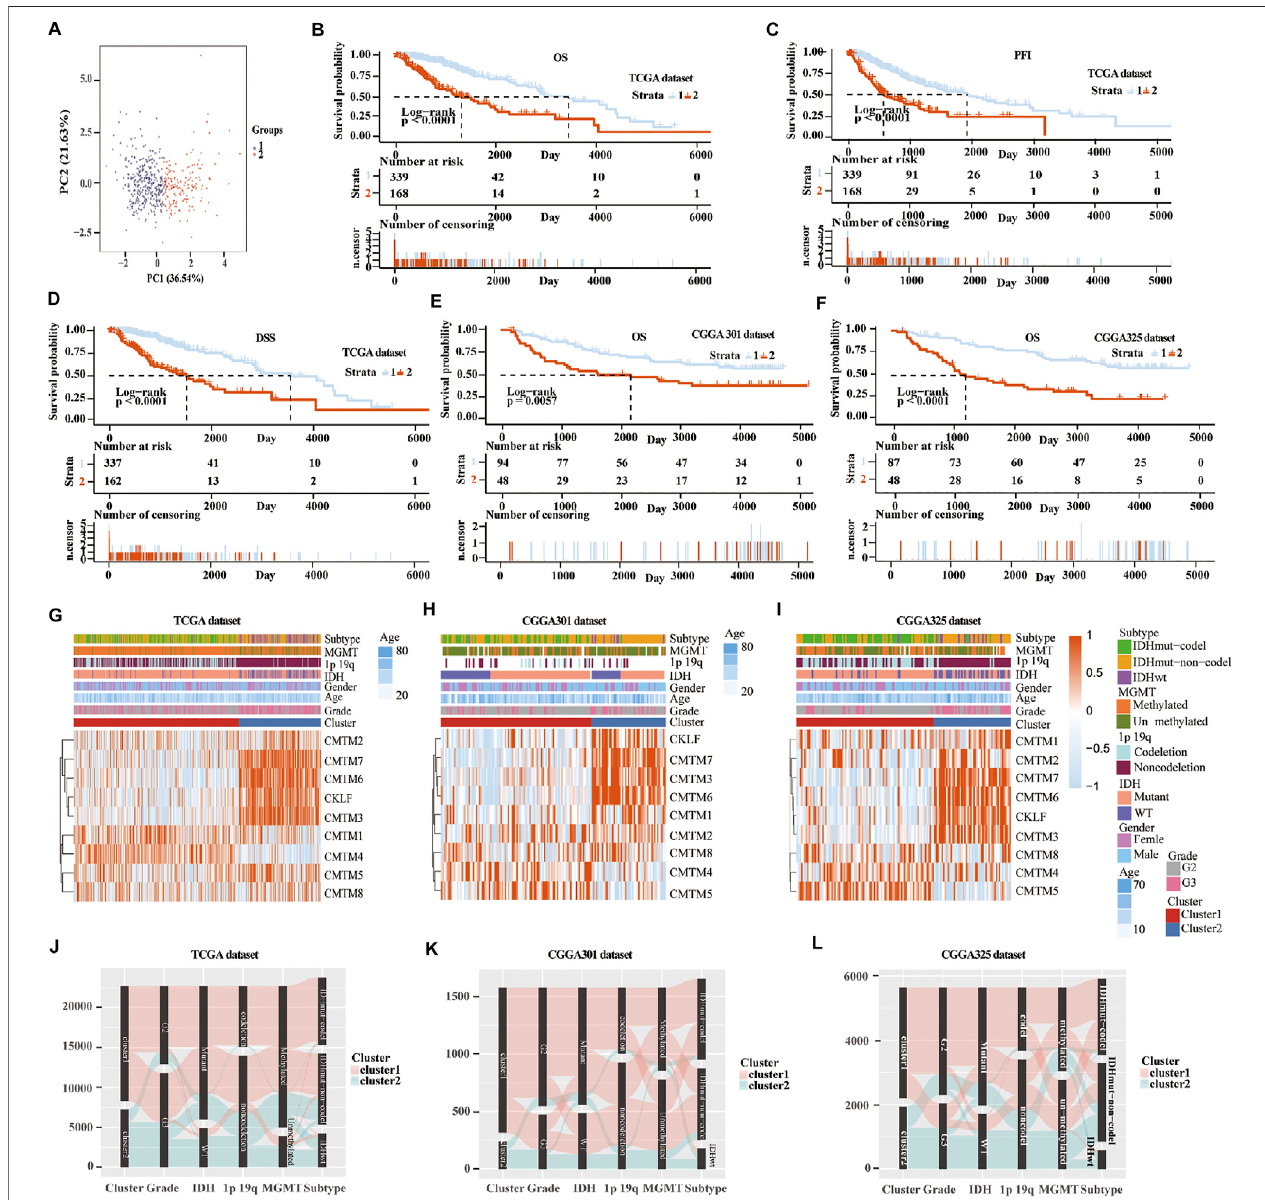
FIGURE 3 | Consensus clustering of samples into cluster 1 and cluster 2 in training and validation cohorts. (A) Principal component analysis (PCA) was applied to exploreanyclusteringbehaviorofthesamplesintheTCGAdatabase.Kaplan-Meieranalysisofpatientsincluster1andcluster2fromtheTCGAdatabaseforOS (B) ,PFI (C) , and DSS (D) . (E) Kaplan-Meier analysis of patients in cluster 1 and cluster 2 from CGGA301 database for OS. (F) Kaplan-Meier analysis of patients in cluster 1 and cluster2fromCGGA325databaseforOS.HeatmapofdifferentgliomasfeaturesandexpressionofCMTMincluster1andcluster2fromTCGA (G) ,CGGA301 (H) , and CGGA325 (I) databases. Sankey diagram of different expression patterns of glioma features in cluster 1 and cluster 2 from TCGA (J) , CGGA301 (K) , and CGGA325 (L) databases, analyzed by the log-rank test.